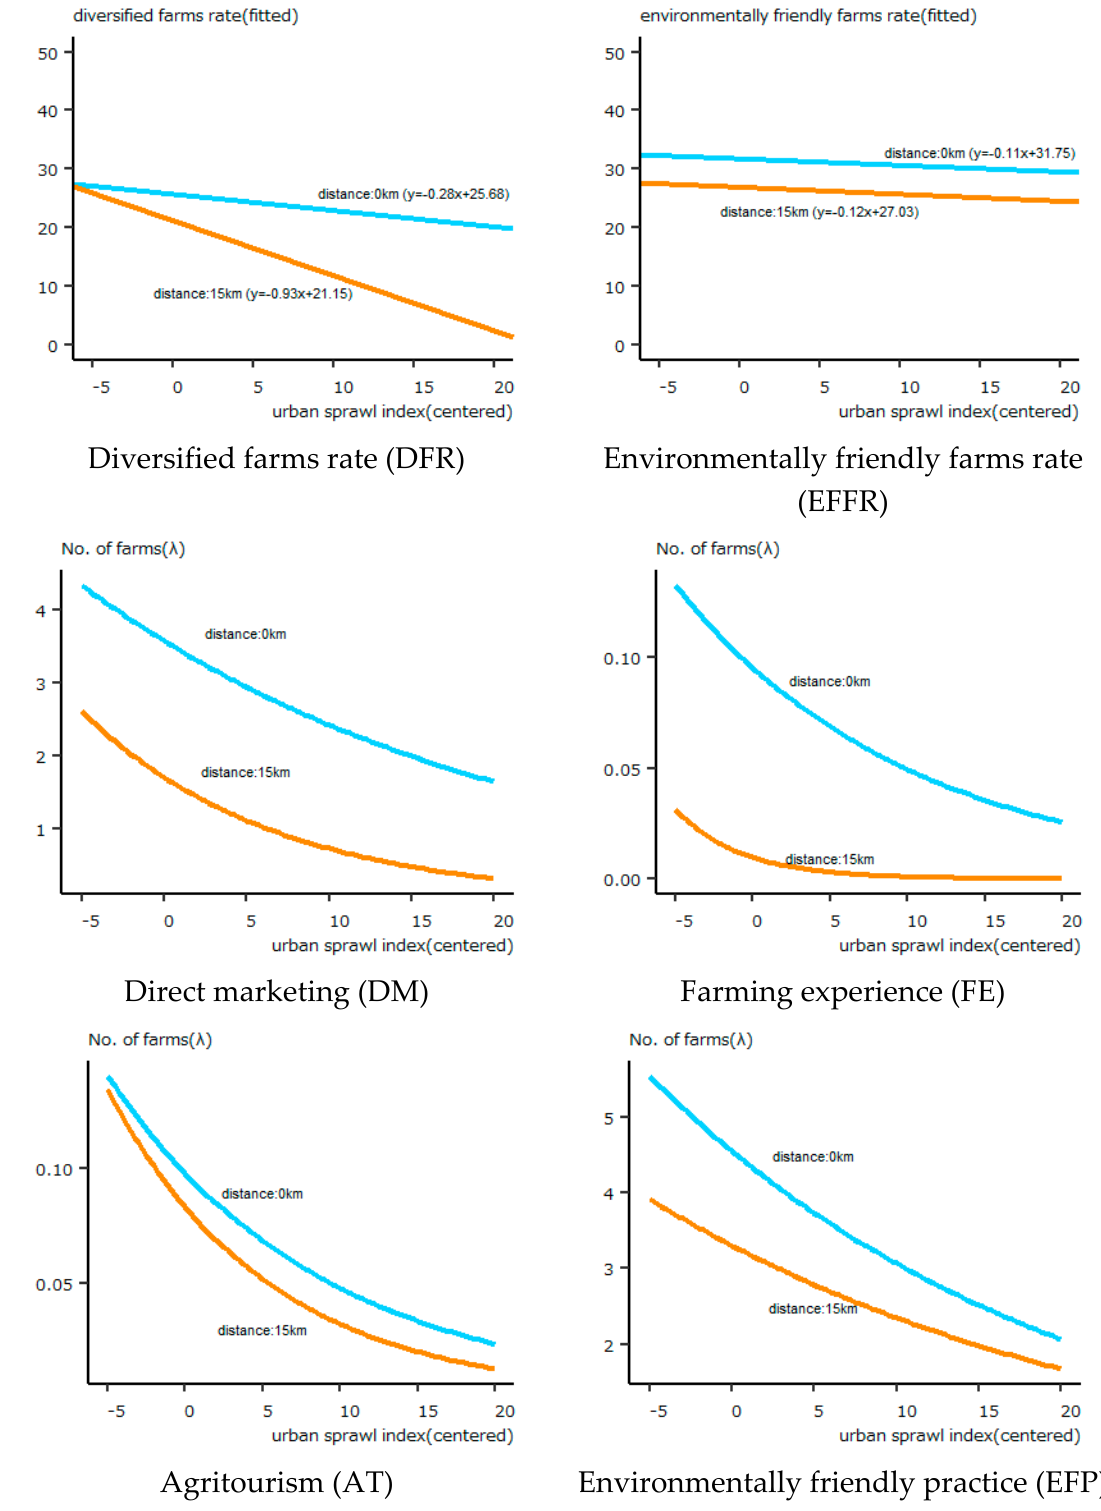
Figure 12. Simulation of regression analysis in the Tokyo metro area. Note: Except for distance and sprawl index, the average values of all variables were substituted in the estimated equation.